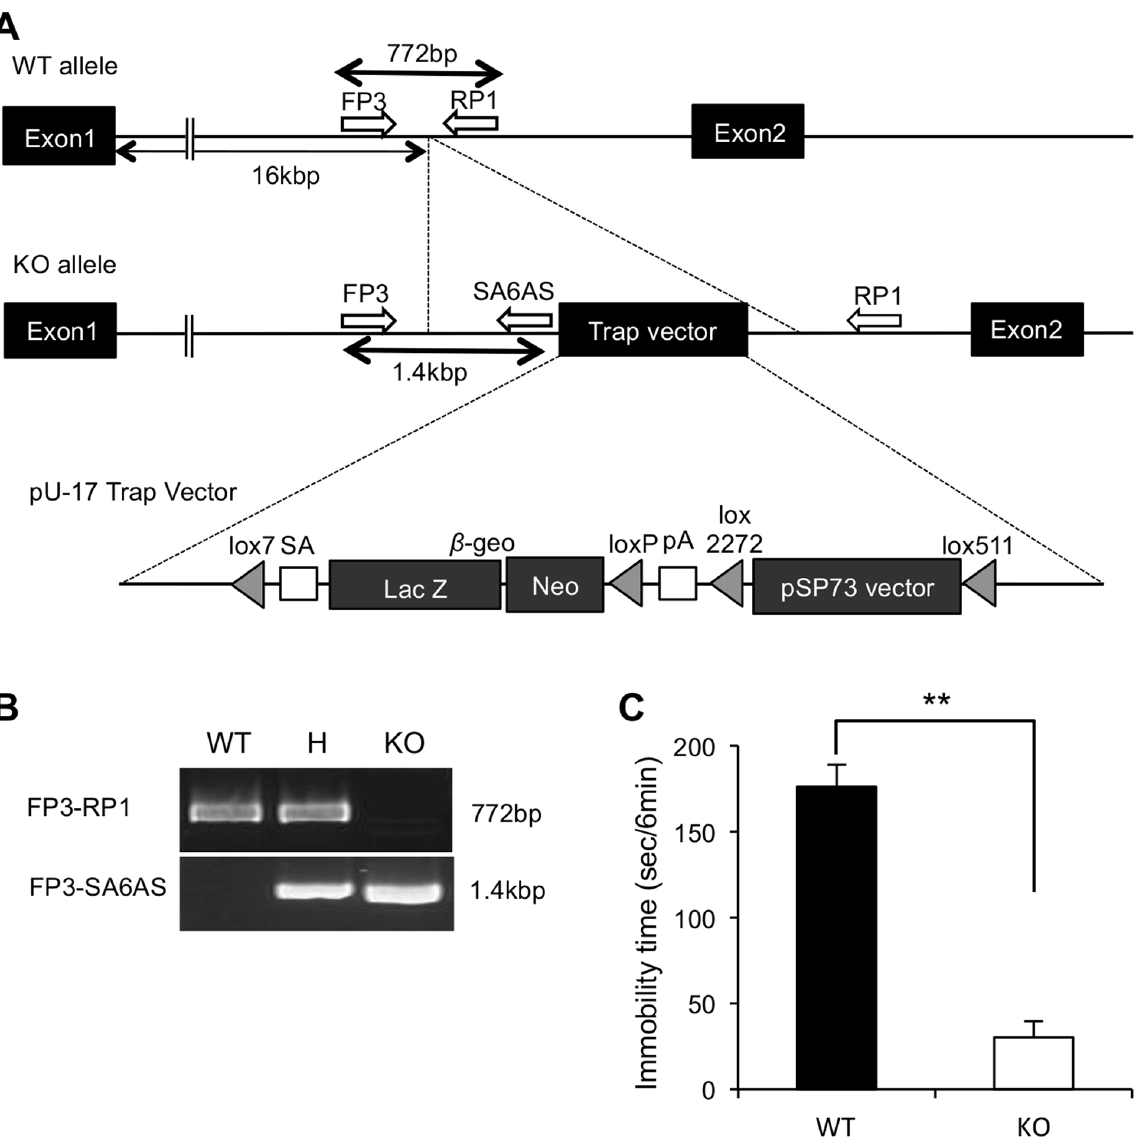
Figure 1. Generation of the Usp46 KO mice. (A) Integration site of the pU-17 trap vector. The trap vector is inserted approximately 16 kbp downstream from exon 1. The trap vector contains a splice acceptor (SA), the b -galactosidase/neomycin-resistance fusion ( b -geo) gene, a polyadeylation signal (pA) and pSP73 vector sequences [10]. The white arrows (FP3, RP1, and SA6AS) indicate the primers used for genotyping. (B) Genotyping by the polymerase chain reaction. DNA fragments of 772 bp from the wild type allele and 1.4 kbp from the inserted allele were amplified by the primer pairs FP3-RP1 and FP3-SA6AS, respectively. (C) Immobility time in wild-type (WT) and Usp46 KO mice (KO) in the tail suspension test (TST). The KO mice showed a significantly shorter immobility time than the WT mice in the TST. Data represent the mean + S.E.M. for 5–6 mice in each group. ** P , 0.01 (Student’s t- test).